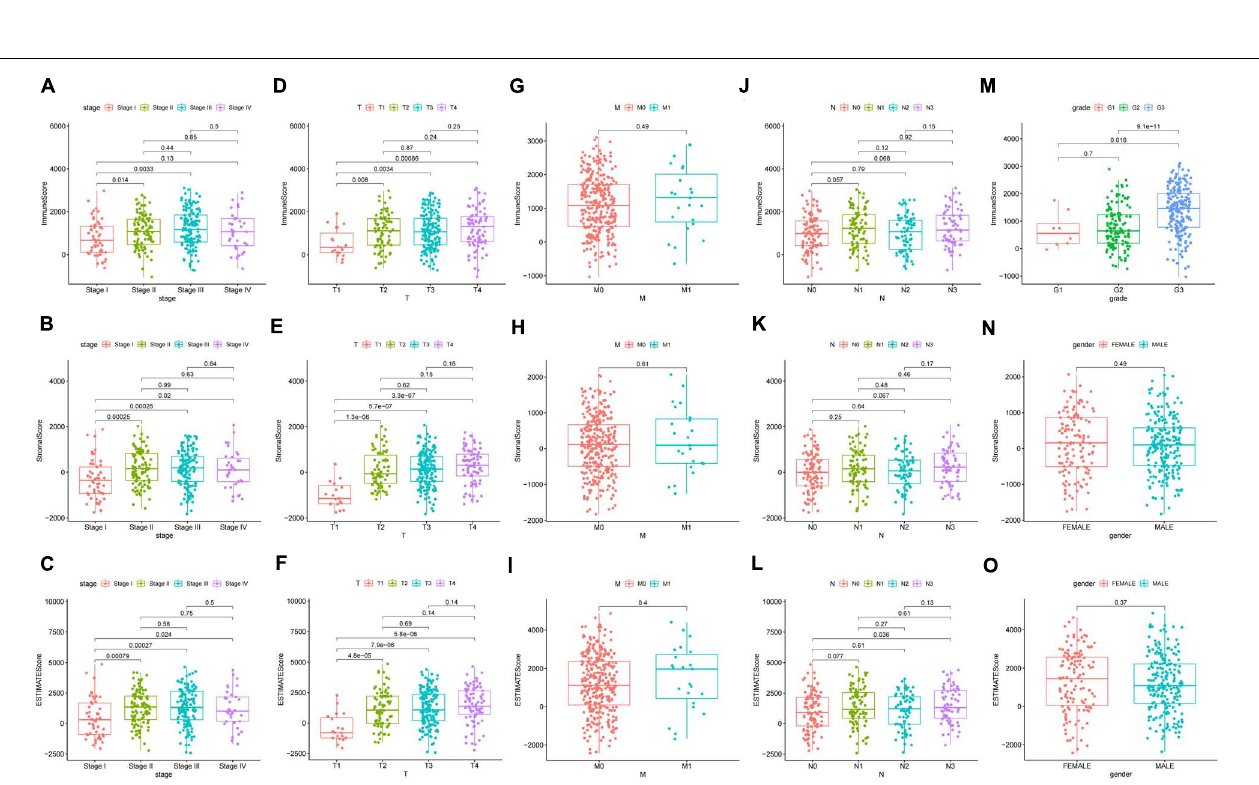
FIGURE 3 | Correlation of clinicopathological characteristics with immune, stromal, and estimate scores (A–O) .